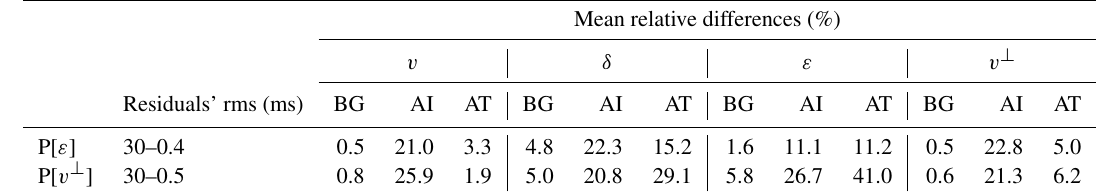
Table 4. Quantification of the quality of recovery in terms of data and model fit for the simultaneous inversion of both parameterizations (Figs. 5 and 6). Initial and final rms values for travel-time residuals to quantify data fit. For each parameter, as a measure of model fit, we computed the mean relative differences between the background areas of the inverted and target models (BG), the anomaly areas of the inverted and initial models (AI), and the anomaly areas of the inverted and target models (AT). Since the initial model is equal to the target model in the background area, it is not necessary to calculate the difference between inverted and initial models for this area. The ideal difference value for BG is 0%. AT and AI indicate the resemblance between true and recovered anomalies, and their ideal values are 0% and 25% ( ∼ 29 . 3% in the case of v ⊥ ), respectively. Recovery is consistent with sensitivity (Fig. 2): v and v ⊥ are well retrieved, ε is only partially recovered with P[ ε ], whilst inversion of δ is unsuccessful in both cases.